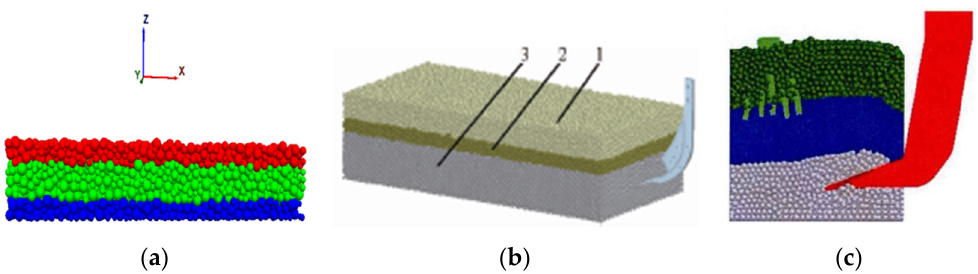
Figure 1. Compound soil model. ( a ) Compound soil model with different layers; (x,y,z reperesents the axes of the 3D DEM model) ( b ) Soil model for subsoiling [23]; ( c ) Root–soil model [40]. 1. Tillage layer 2. Plow-pan layer 3. Subsoil layer.